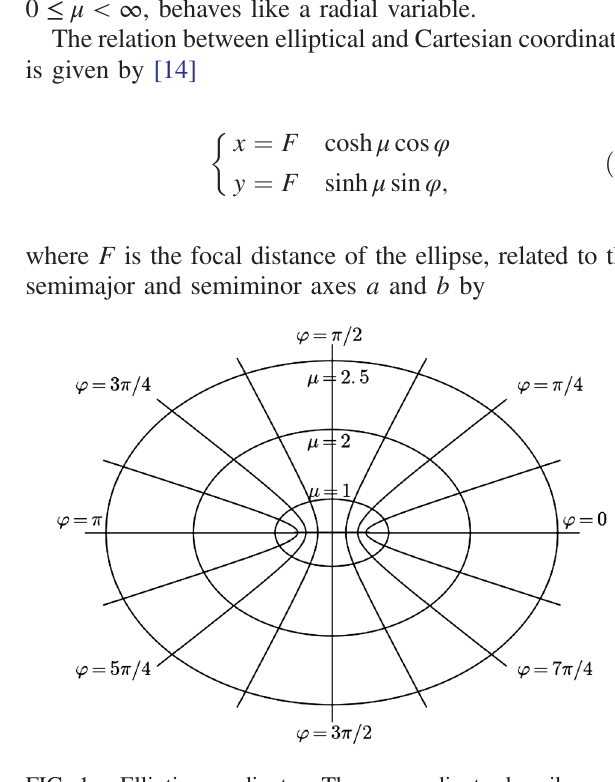
FIG. 1. Elliptic coordinates. The φ coordinate describes con- focal hyperbolas that are symmetrical about the x-axis. The μ coordinate describes confocal ellipses centered on the origin of the coordinate